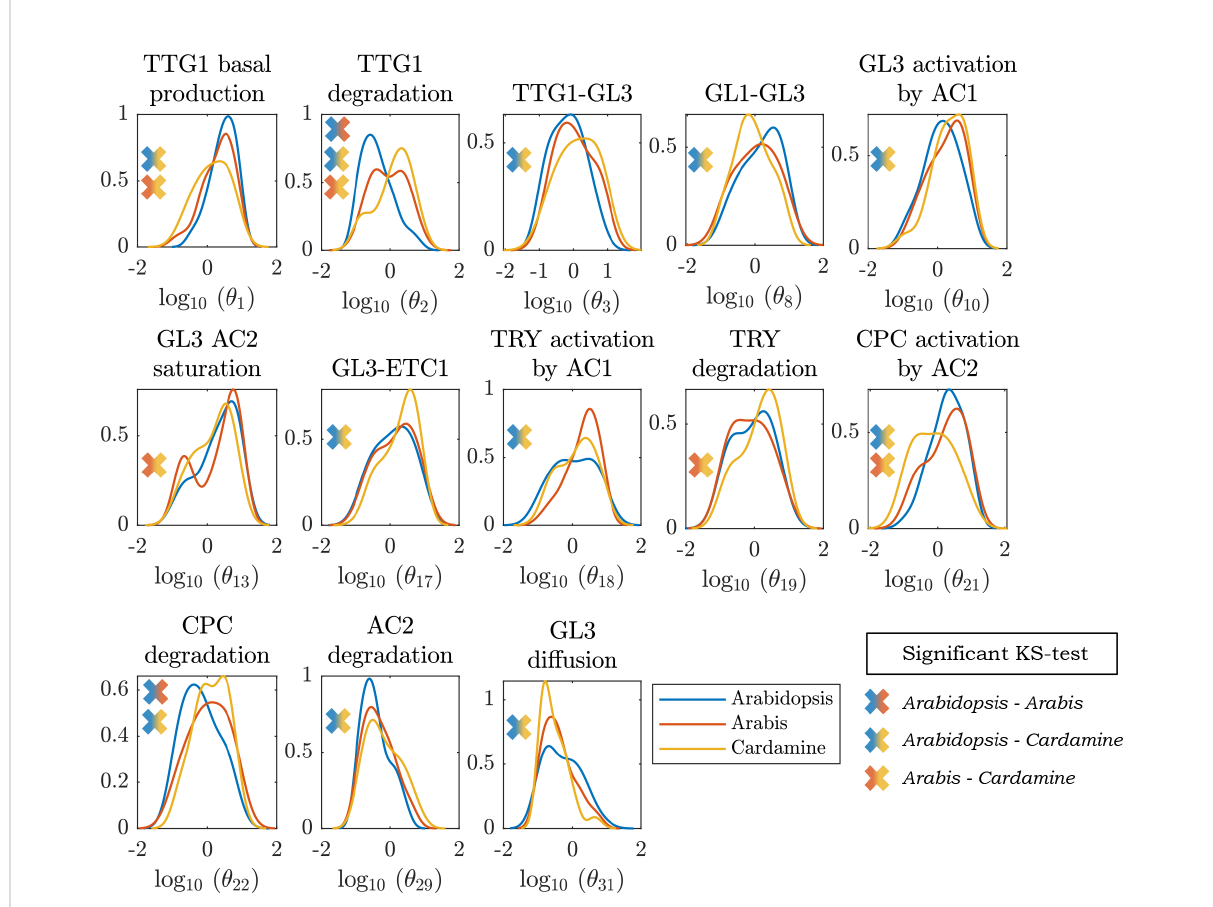
FIGURE 4 Parameter pro fi le densities. Parameter distributions that differed between the species according to a Kolmogorov-Smirnov test, obtained from fi tting the model output to the qPCR data. The crosses indicate between which pair of species the distributions were found to statistically differ. The titles indicate the biological interpretation behind the parameter q i on the